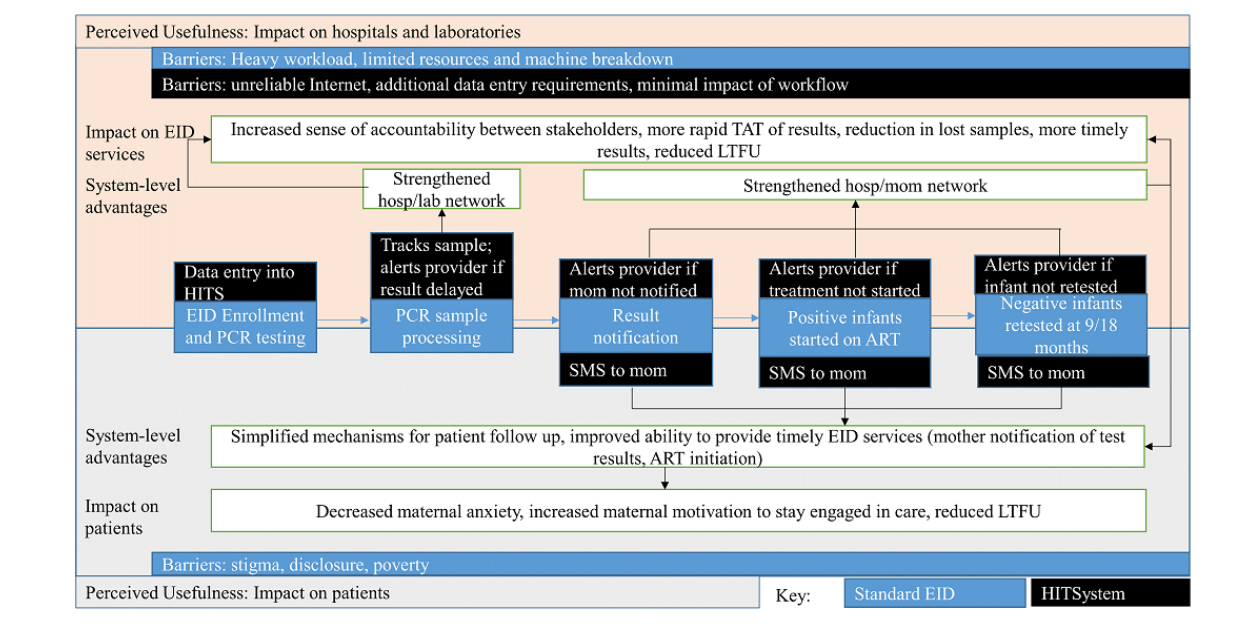
Figure 1. Perceived usefulness of the HIV Infant Tracking System (HITSystem). ART: antiretroviral therapy; EID: early infant diagnosis; LTFU: